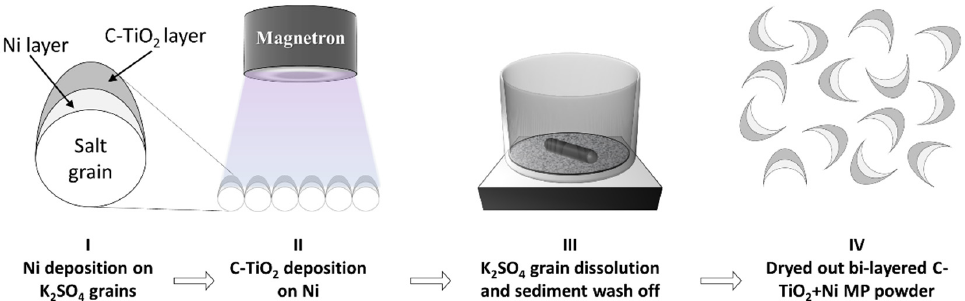
Figure 10. Schematic view of magnetic photocatalyst powder synthesis procedure.